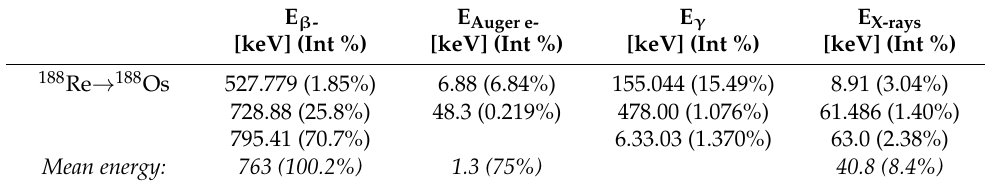
Figure 3. 188 Re simplified production and decay scheme. Table 2. 188 Re detailed nuclear decay data [7,9].